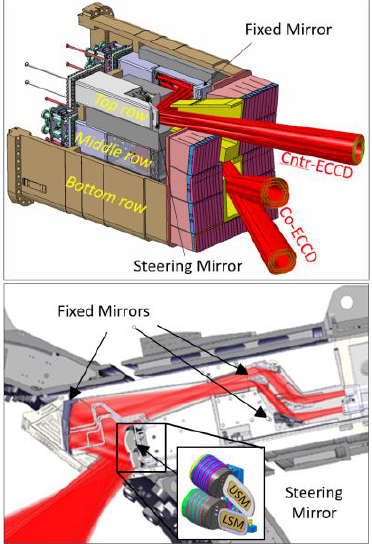
Fig. 3: Geometry of the EC Upper Launchers with the static and steering mirrors. Top: Equatorial Launcher; Bottom: Upper Launcher. In red are represented the beams that propagate inside the launchers.